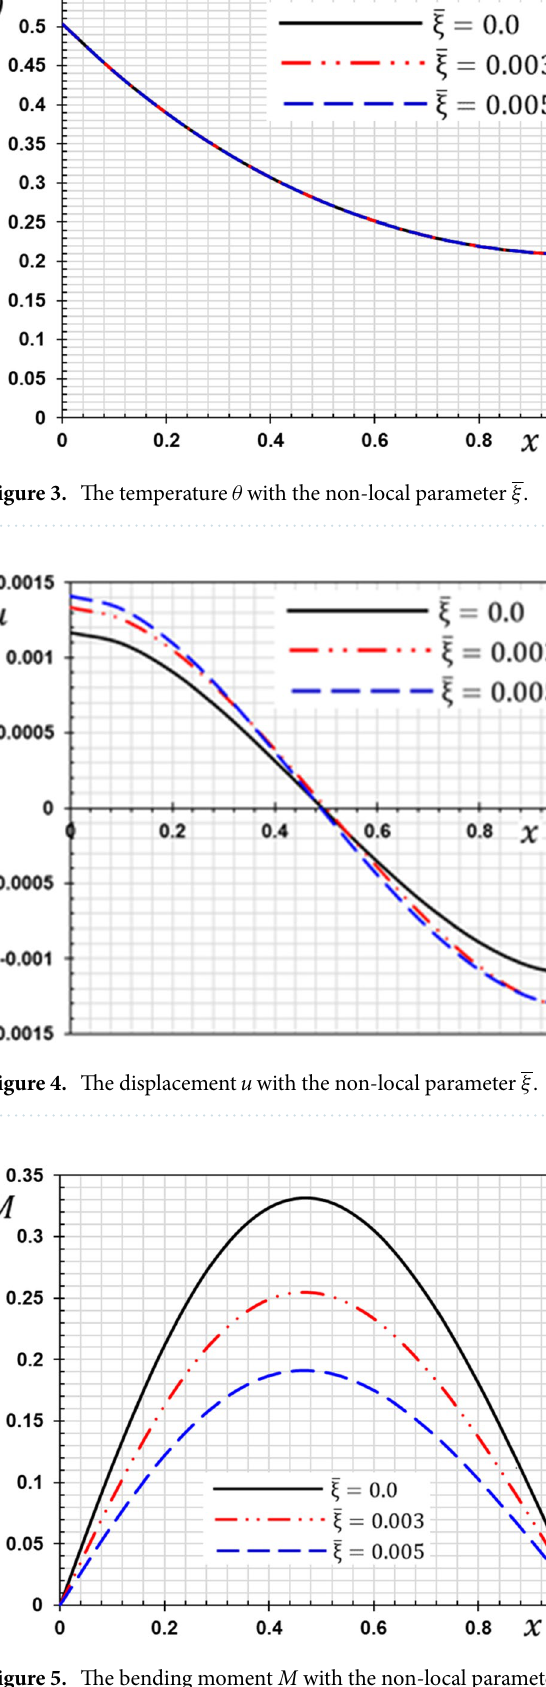
Figure 5. The bending moment M with the non-local parameter ξ